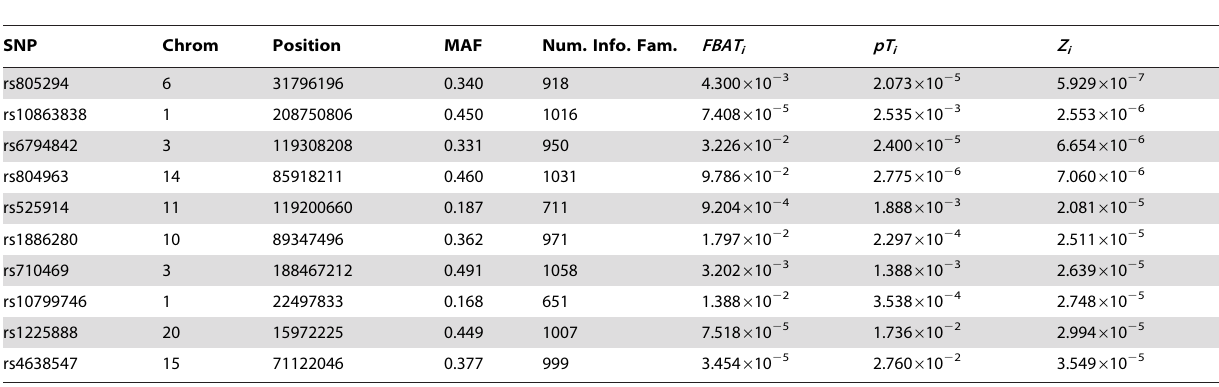
The number of markers is 306,264 and the genome-wide significance level at 0.05 is 1.636 6 10 2 7 . The top 10 SNPs from Z i are selected, assuming additive disease mode of inheritance. For pT i , the estimated powers are used and the weights for LIP are calculated with the number of informative trios. doi:10.1371/journal.pgen.1000741.t006 13:13:5:1 =FHS:BBC:CAMP:ACG as weights because the be- tween-family information is used only for FHS. If the p-value from Illumina gene chip in BBC and the p-values from FHS, CAMP